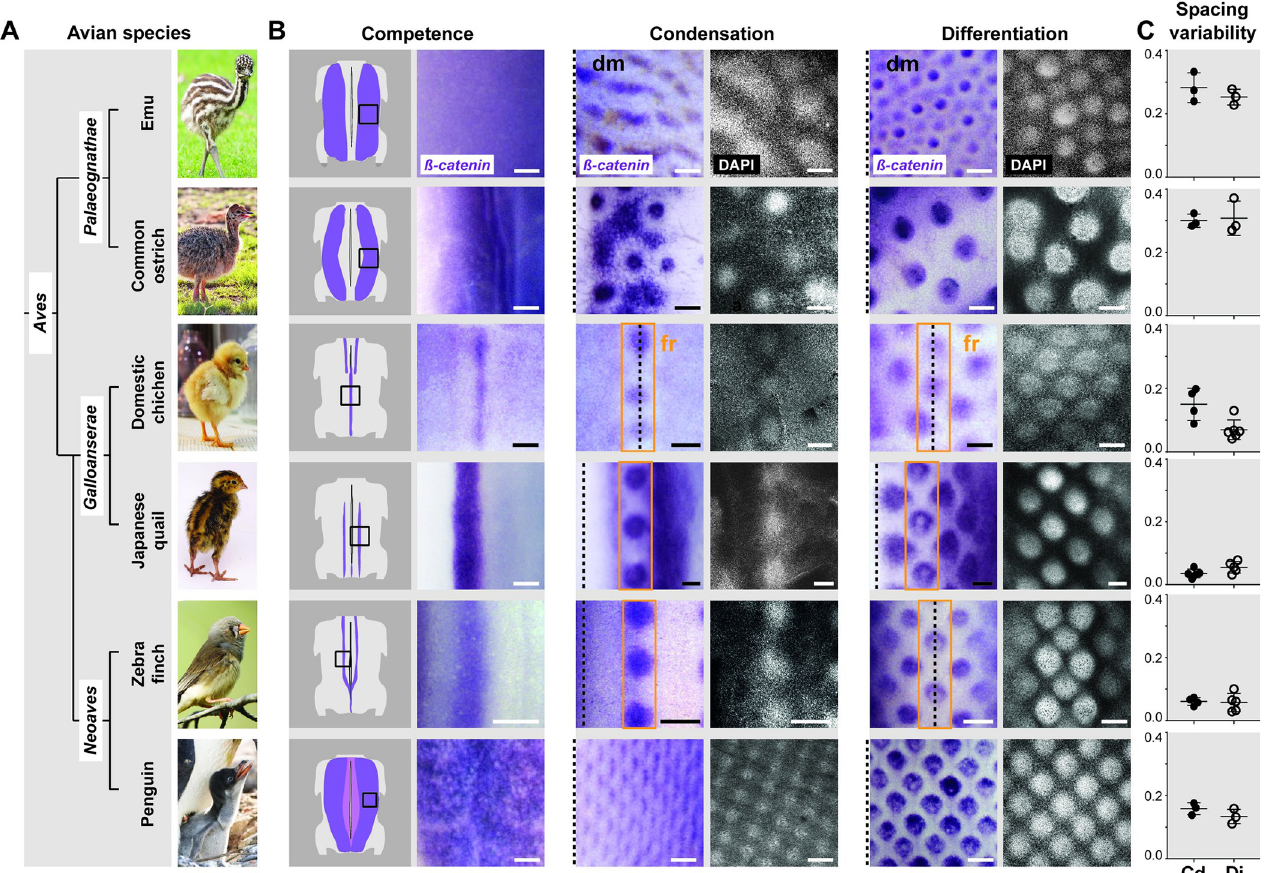
Fig 2. Natural variation in primordia array geometry between avian species. (A) Juveniles of chosen bird species represent the 3 major clades of the avian phylogeny. (B) The earliest distribution of β -catenin transcripts (in purple) in competent longitudinal segments or areas (i.e., at competence stage, first column) is shown on schematics of embryonic dorsum and images corresponding to black squares. At condensation stage (middle column), β -catenin was restricted to nascent primordia, also visualized with DAPI stains (in white, 10 × confocal views), showing that species differ in timely dynamics of primordia emergence (i.e., in a row-by-row wave or simultaneously). At differentiation stage (right column), species-specific primordia array geometries had formed. Black dotted lines indicate the position of the dorsal midline (dm); orange boxes show the first-formed primordia row (fr) in species displaying a row-by-row wave. Scale bars: 200 μ m. (C) Quantifying standard deviations of distances between adjacent primordia (spacing variability, in a dimensionless number defined in Materials and methods and see S2 Fig) along segments or areas at condensation (Cd) and differentiation (Di) stages showed that species vary in the regularity of their primordia pattern. Error bars: mean with standard deviation. The data underlying this figure can be found at 10.5281/zenodo.7006365. Photo credits: Jooin (emu), Barbara Fraatz (Pixabay, common ostrich), Publicdomain pictures (domestic chicken), Manceau laboratory (Japanese quail), Wikimedia (zebra finch), and Raphae¨l Sane´ (www.raphaelsane.com, Gentoo